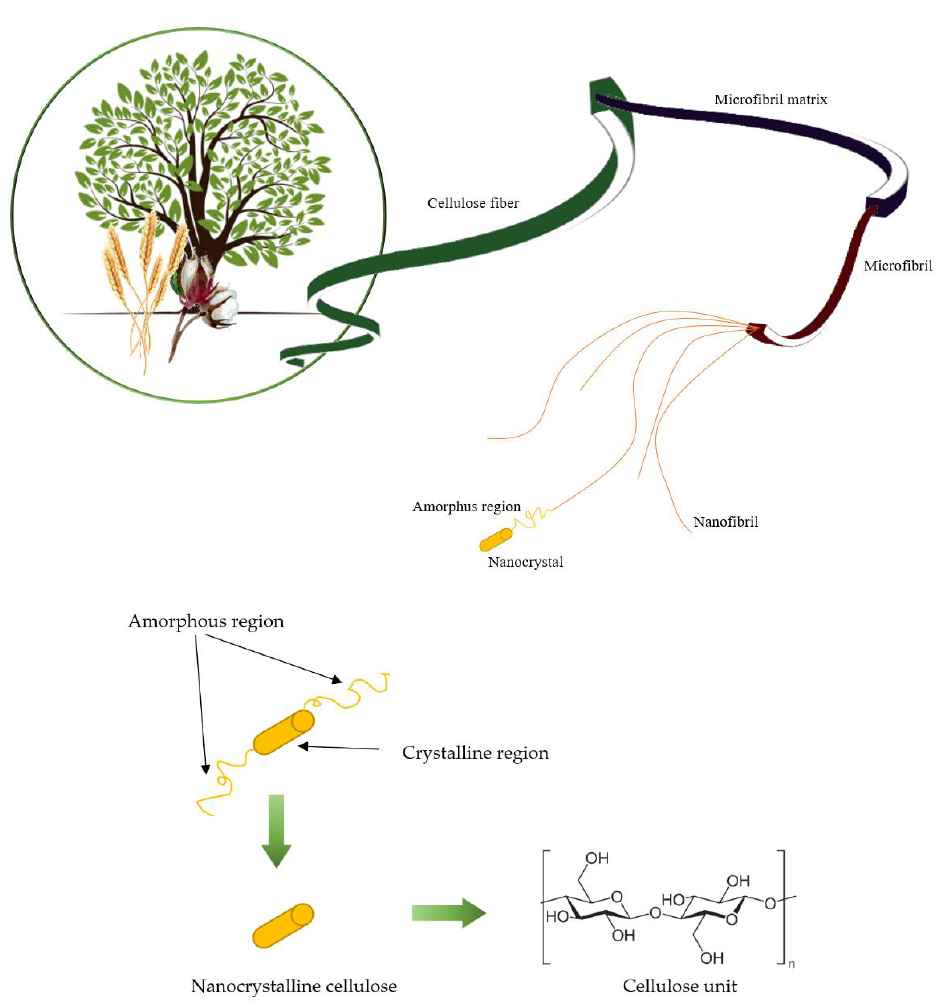
Figure 1. From cellulose fibers to nanocellulose. Cellulose is nature ’ s most abundant biopolymer and a significant component of the plant cell wall. Besides plants, cellulose can be synthesized by bacteria or found in algae and tunicates [39,55]. Chemically, cellulose consists of D-glucopyranose units linked by β -1,4-glycosidic bonds, with a repeating cellobiose unit organized into fibers. Cellulose can be found in seven allomorphs (cellulose I α , I β , II, III I , III II , IV I , and IV II ), of which cellulose I is the most crystalline in structure. Cellulose I β is more thermally stable than cellulose I α because there are weaker hydrogen bonds in cellulose I α than in cellulose I β .